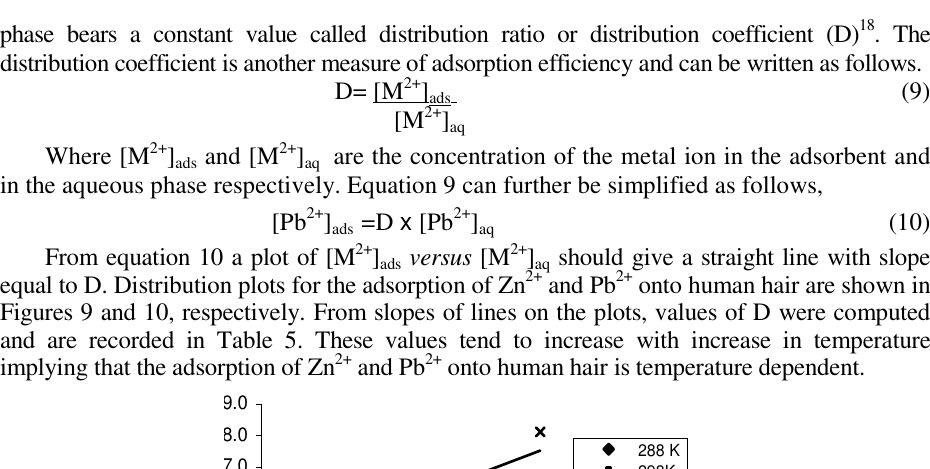
Figure 9. The plot of [Zn 2+ ]